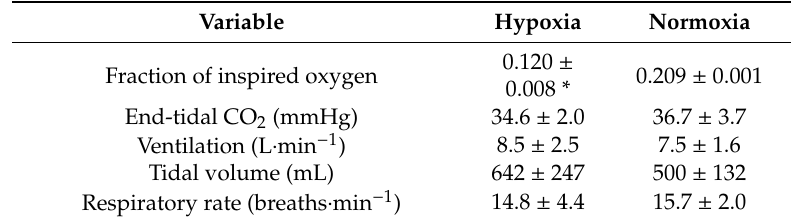
Table 3. Average values for variables of pulmonary gas exchange for the last minute of the five cycles of intermittent hypoxia and intermittent normoxia.